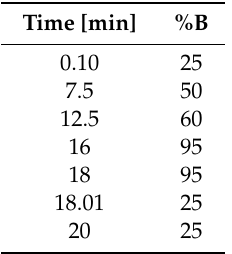
Table 6. Gradient table for chromatographic separation (Mobile phase A: 0.1% formic acid in